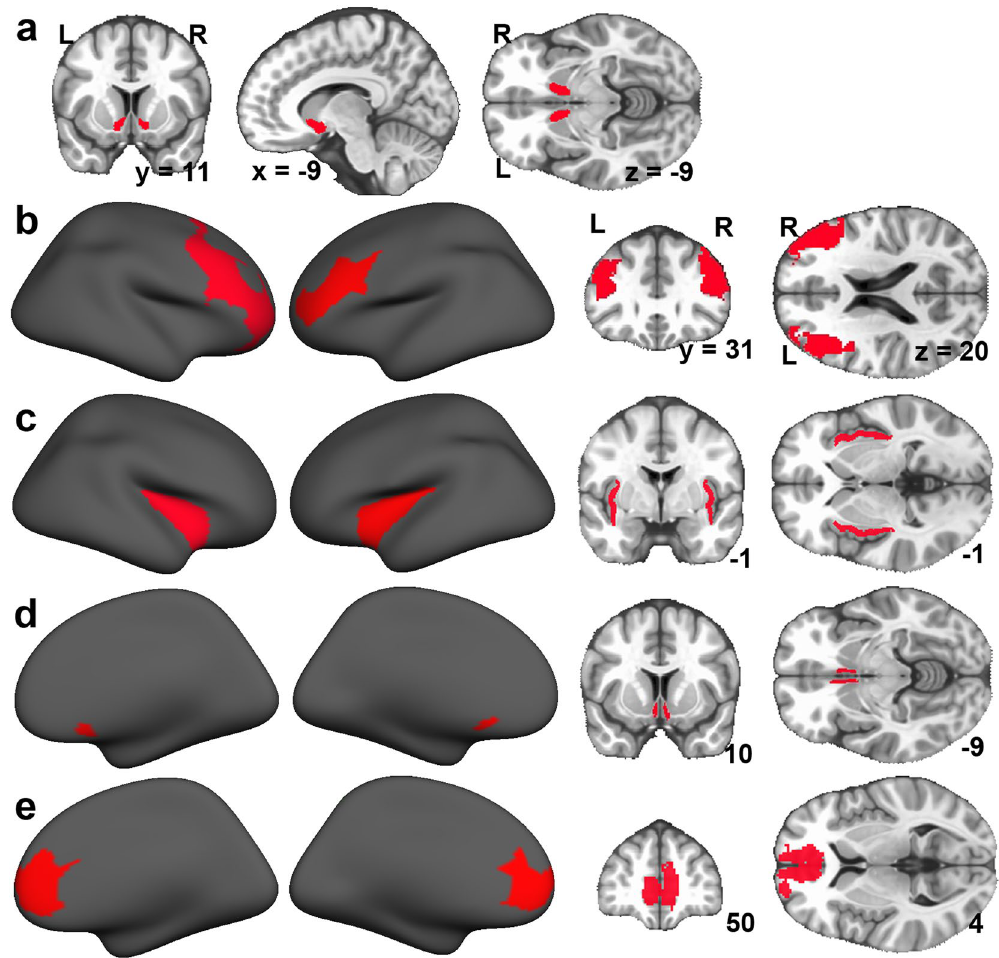
Figure 1. Regions of interest (ROIs). FreeSurfer’s automatic segmentation was used to identify nucleus accumbens (NAcc, a ) 96 . Lateral prefrontal cortex (LPFC) ( b ) was defined from the Yeo resting-state atlas 7-network atlas 101 as the prefrontal lateral components of the frontoparietal network. Insula ( c ) was defined using the Desikan 99 parcellation and subgenual anterior cingulate cortex (sgACC, d ) was defined using the Destrieux 100 parcellation, both implemented in FreeSurfer. Medial prefrontal cortex (mPFC, e ) was defined from the Yeo resting-state atlas 17-network atlas 101 as the medial prefrontal components of the default mode network. Renderings are depicted on an MNI template. The MNI ICBM 152 version 2009 high-resolution 0.5 × 0.5 × 0.5 mm symmetric template brain 94 resampled to quantitative magnetic resonance imaging (qMRI) resolution was used as the volumetric image underlay, and volumetric coordinates are in MNI space. Note that both Nacc and insula ROIs were defined in individual native space but are depicted on MNI